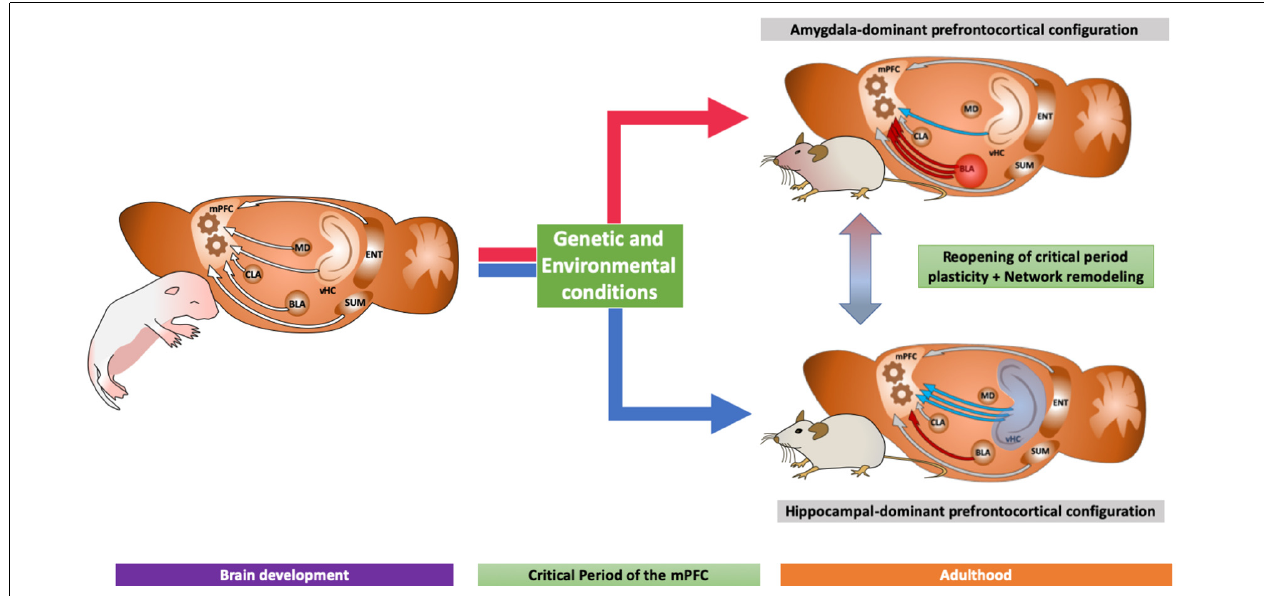
FIGURE 2 | Diagram showing two different neurodevelopmental trajectories according to its prefrontocortical inputs: (1) an amygdaloid-dominant scenario, with strong projections from the basolateral amygdala to the mPFC, with increased volume in the amygdala which, as discussed in the main text, is related to increased fear expression and neuropsychiatric disorders; and (2) a hippocampal-dominated network, associated to antidepressant action and increased neuroplasticity. We also indicate the possibility of new treatments able to revert the network configuration as explained in the main text.